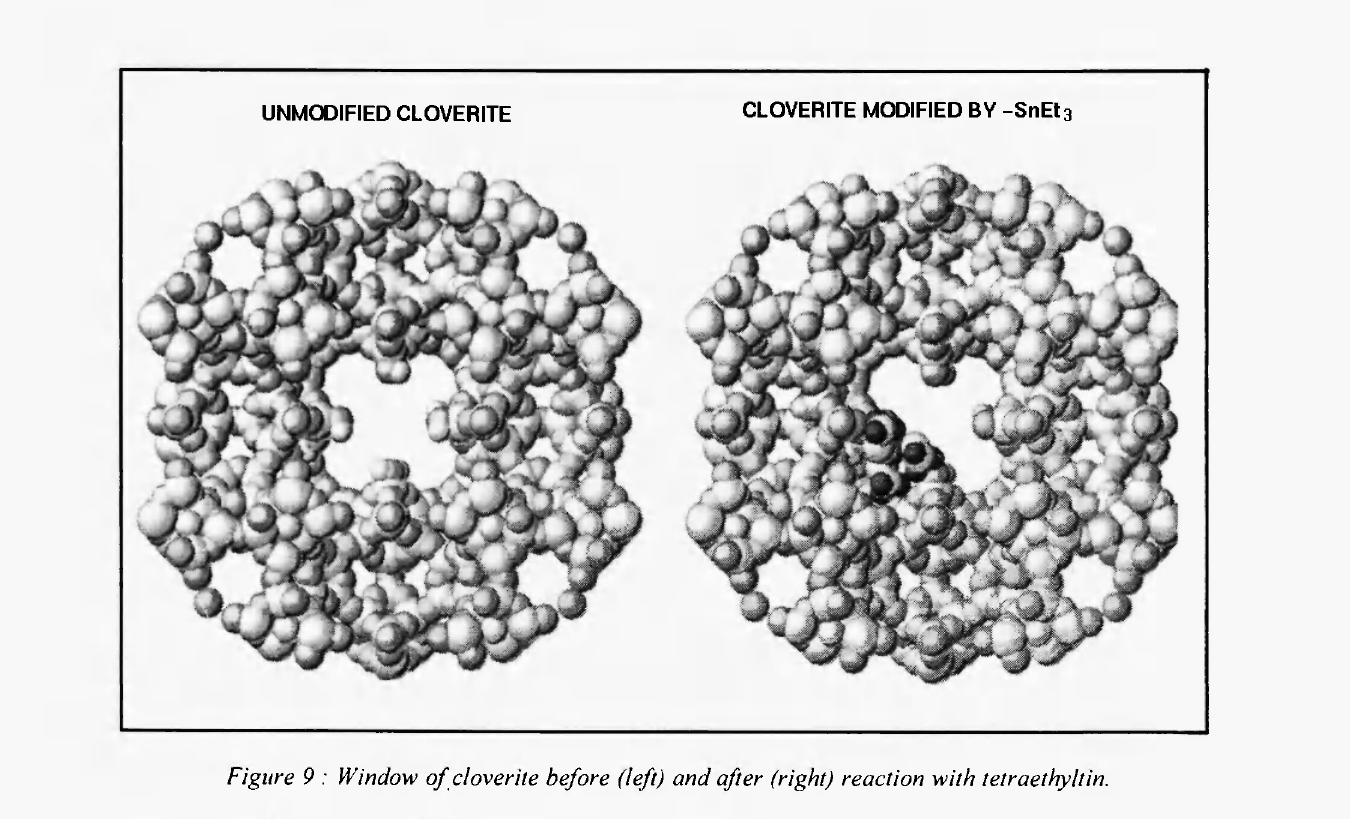
Figure 9 : Window of cloveriie before (left) and after (right) reaction with tetraethyltin. Grafting reaction of tetramethyltin in the supercages of